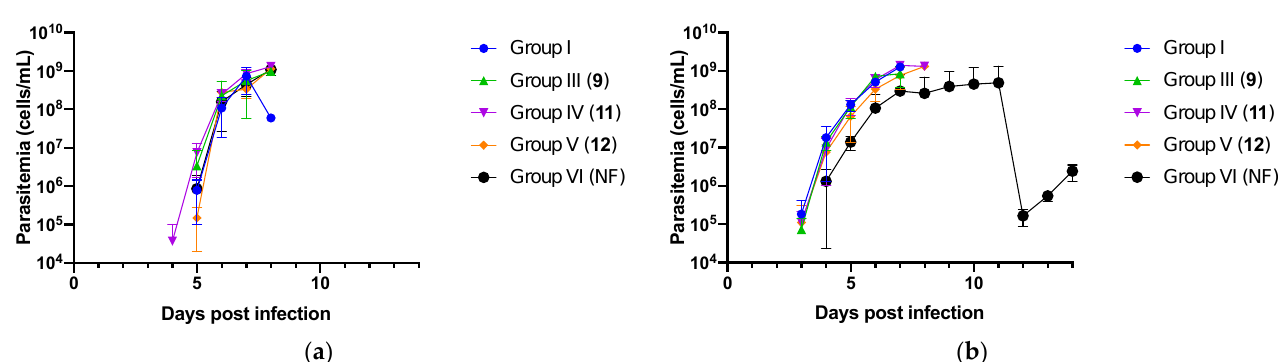
Figure 1. In vivo analysis of selected nitrofurantoin analogs and nitrofurantoin (NF). Evaluation of parasitemia in mice infected with T. congolense and intraperitoneal or orally treated with nitrofurantoin analogs ( 9 , 11 , and 12 ) and nitrofurantoin. The Y axis shows log 10 scale, and the data are shown as mean ± standard deviation. Parasitemia was not observed in group II (diminazene aceturate treatment). ( a ) Treatment of mice by intraperitoneal injection at 0.1 mg/kg. ( b ) Treatment of mice by oral administration at 10 mg/kg.